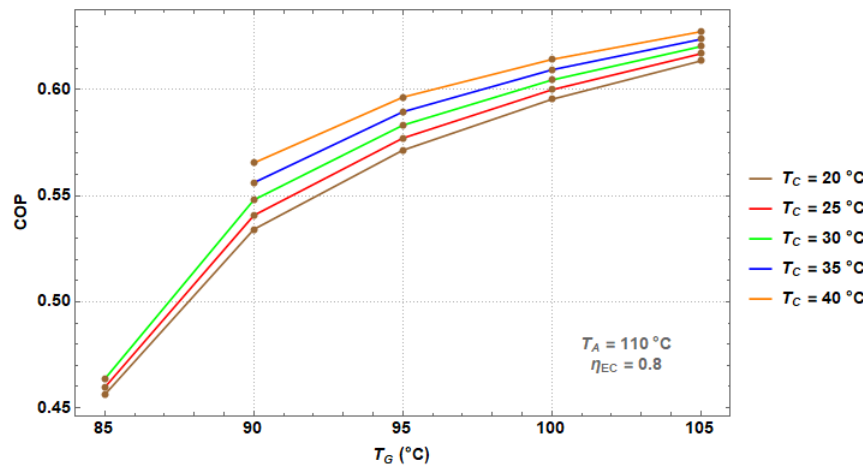
Figure 6. COP as a function of T G at different T C values for the DEHT.